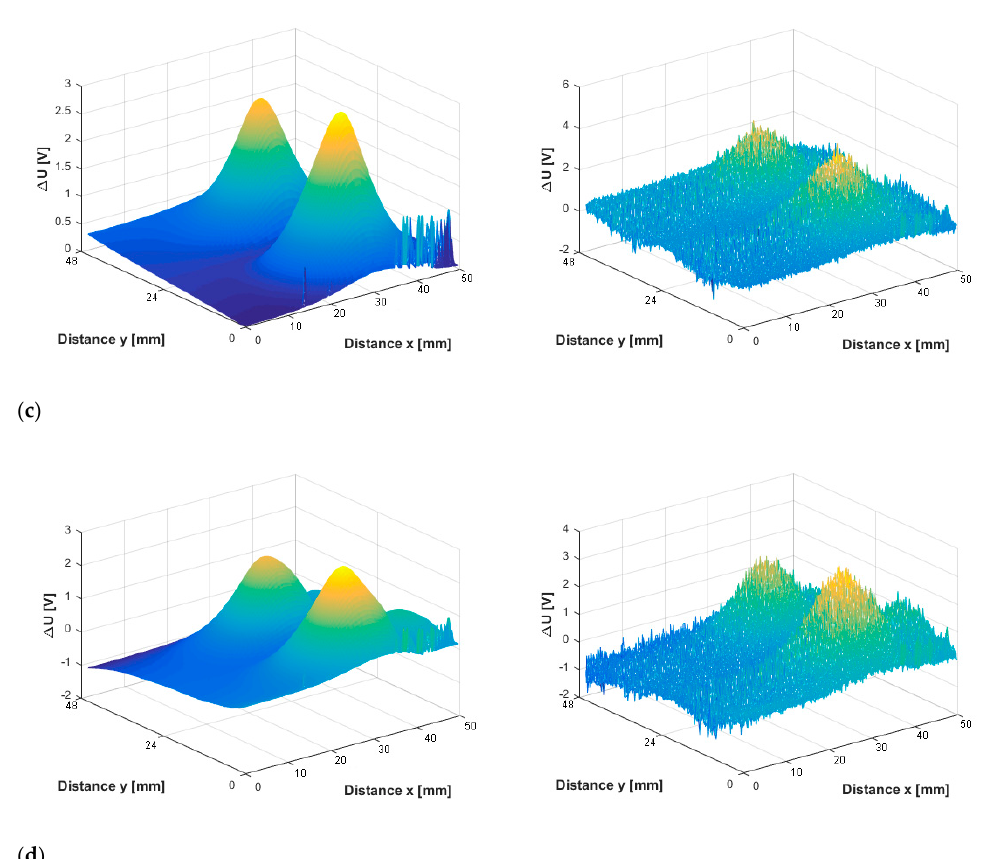
Figure 7. Eddy current responses due to an EDM notch measured during 2-dimensional scanning over a cracked region.